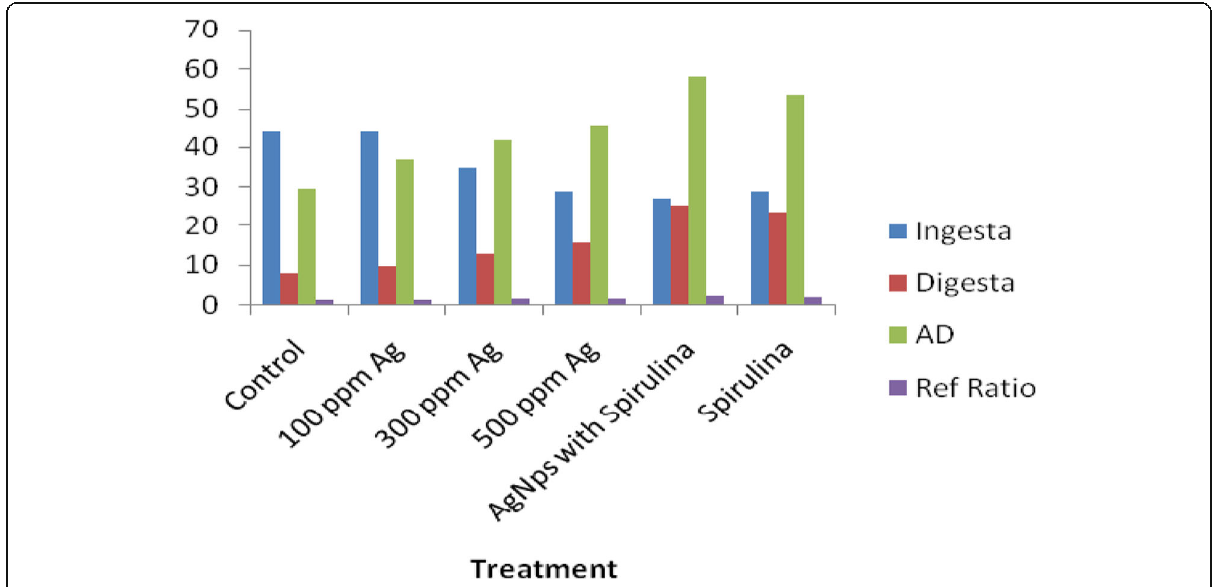
Fig. 3 Comparison of ingesta, digesta, approximate digestibility, and reference ratio of treated silkworm groups